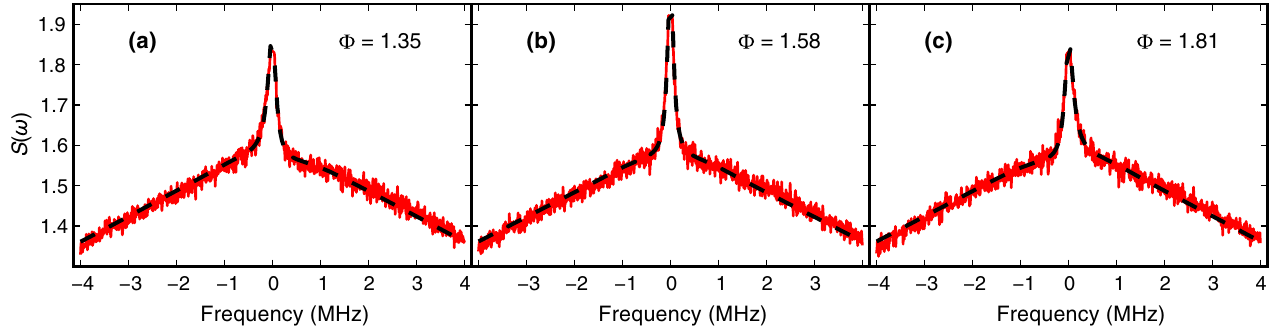
6 . 6 dB. The spectra are measured near Φ ¼ π = 2 , the relative phase between the FIG. 7. Mollow triplet spectra measured at G JPA ¼ squeezed-vacuum and coherent-drive fields that minimizes the center-peak linewidth. Even though the Rabi frequency (1.2 MHz as in Fig. 3) is small compared to the measured frequency range, the sidebands are broadened such that they are no longer apparent. The dashed black line represents the best fit to the power spectra, taking into account both the fluorescence spectrum and the frequency- dependent squeezer background. The spectra are simultaneously fit with γ fixed by measurements of the Mollow triplet in ordinary vacuum and also constrained by the relative phase difference between each measurement. From these measurements, we infer M − N ¼ 0 . 24 for these